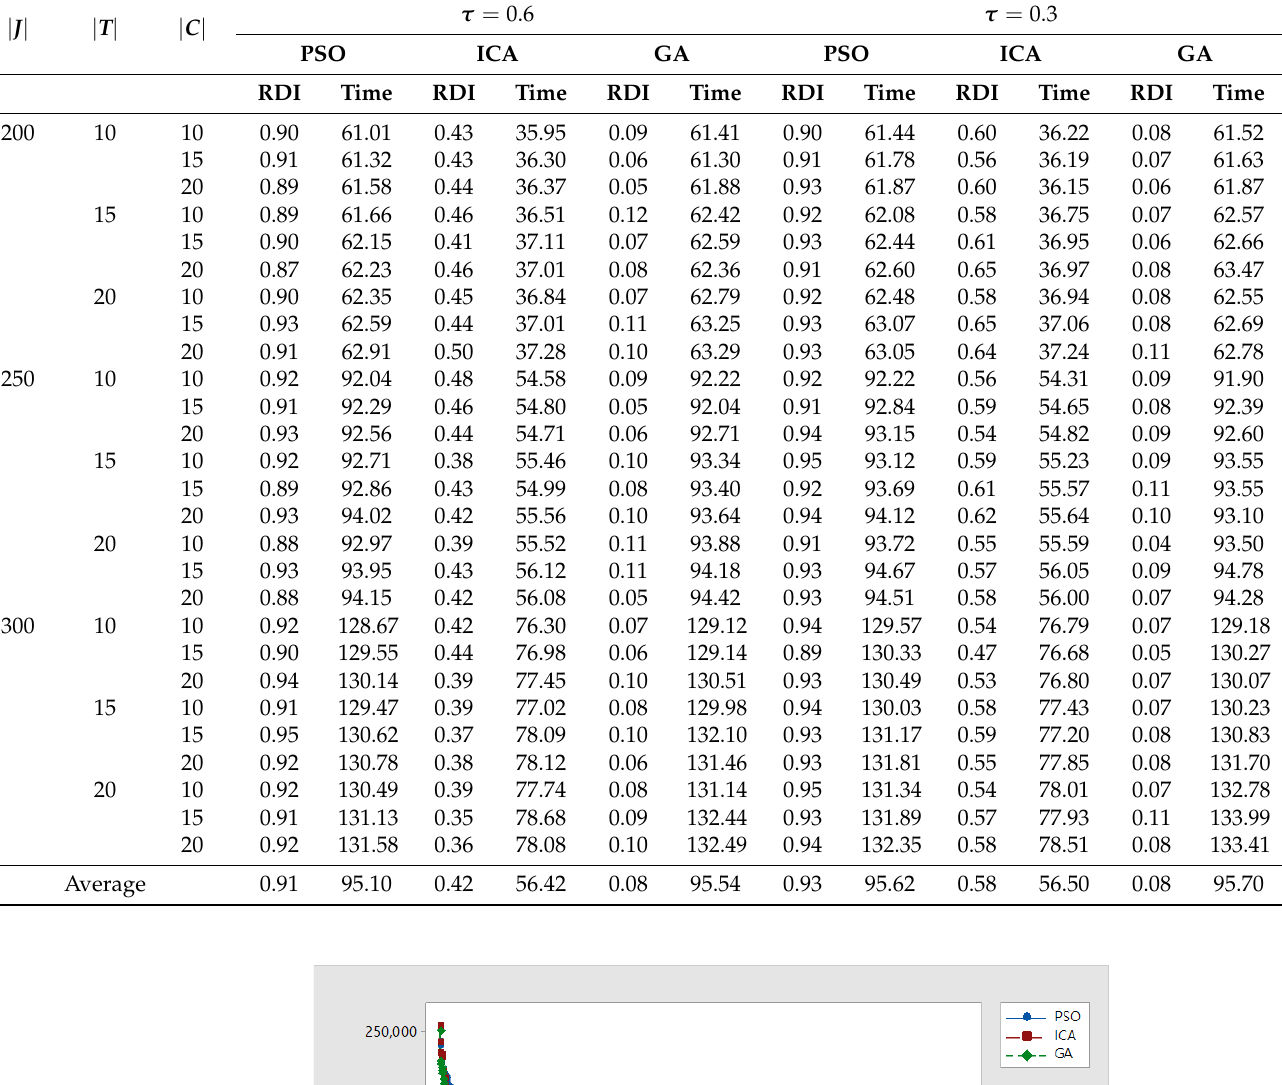
Table 7. Computational results for large problem instances.